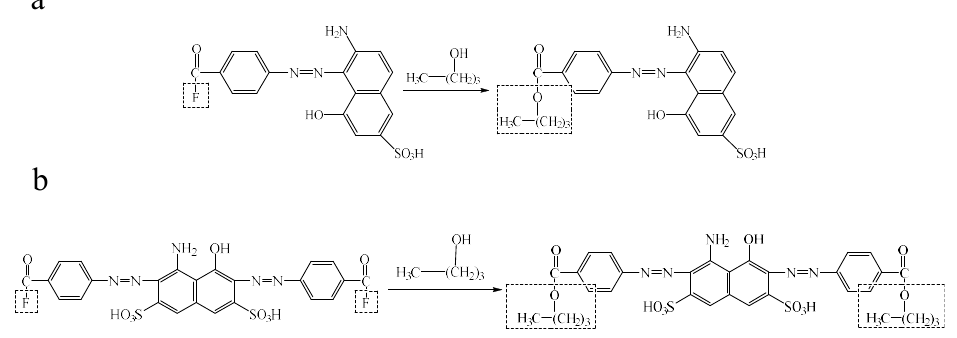
Scheme 2. Simulated dyeing process response of Dye-1 ( a ) and Dye-2 ( b ).